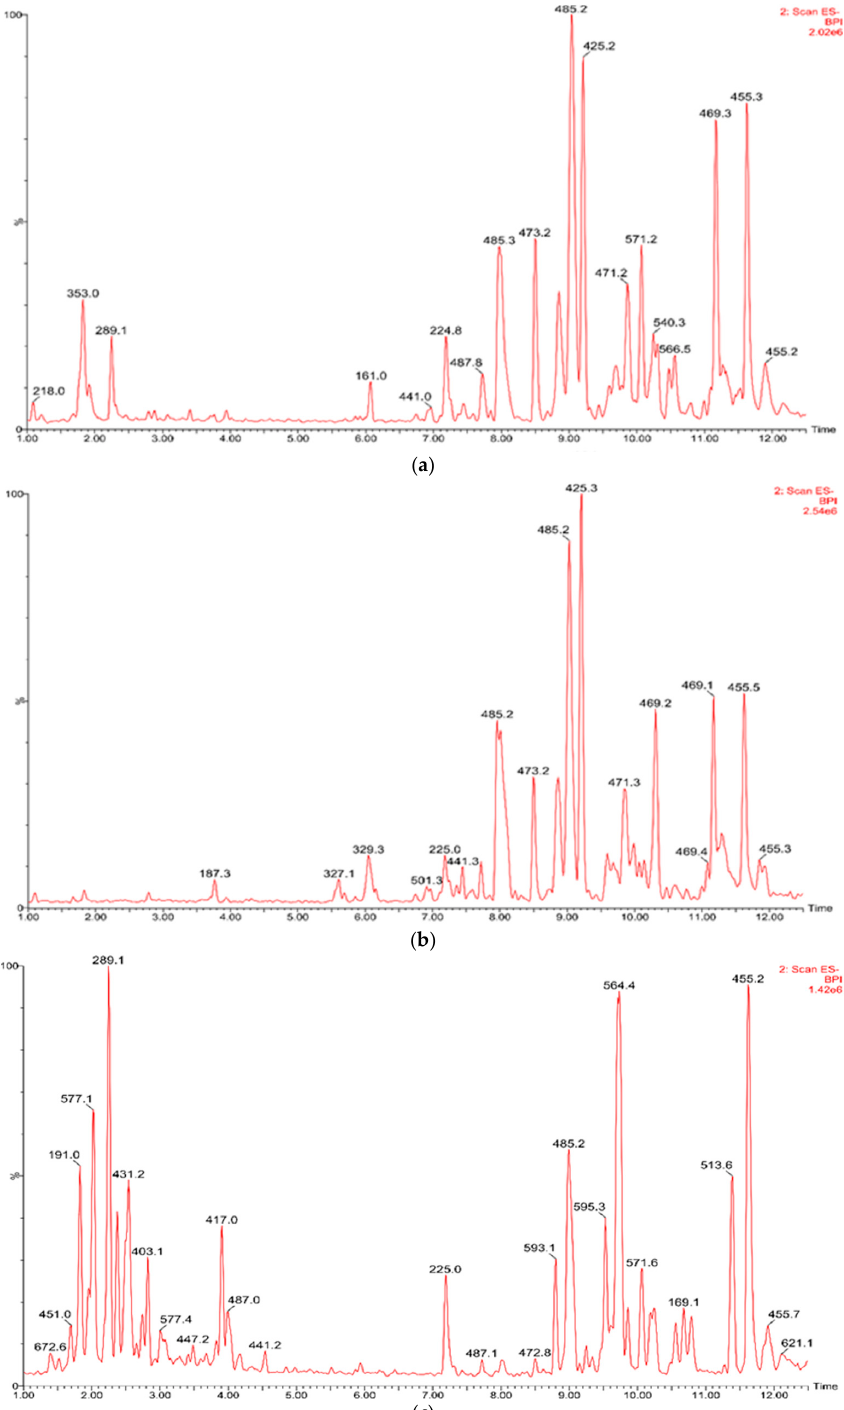
Figure 2. The High Performance Liquid Chromatography Tandem Mass Spectrometry (HPLC-MS/MS) chromatograms of extracts from Chaenomeles japonica ( a ) callus A1 ( b ) callus A2 ( c ) fruits. Figure 3 shows the morphology of the control fibroblasts and those treated with C. japonica extract from the callus A2 line in the selected concentrations and time